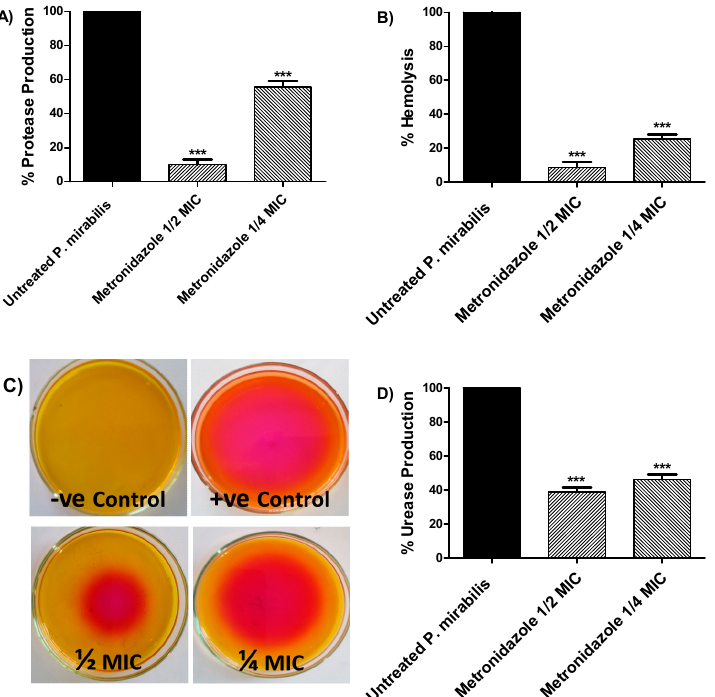
Figure 2. Effect of metronidazole in sub-MIC on P. mirabilis virulence enzymes. One-way ANOVA test was employed to compare between the metronidazole in ½ MIC or ¼ MIC treated and untreated bacterial cultures. The data were presented as mean ± standard error of percentage change from untreated cultures; and were considered statistically significant when p values < 0.05. ( A ) Protease production: significantly, metronidazole reduced the protease production in comparison to untreated cultures ( p < 0.0001). ( B ) Hemolytic activity: metronidazole in sub-MIC significantly decreased the hemolytic activity ( p < 0.0001). ( C , D ) Urease inhibition: Christensen’s urea agar plates containing different sub-MIC of metronidazole were used. The change in the color of the pH indicator from yellow to pink indicates the urease activity and pink zones were measured in mm. Metronidazole significantly reduced the production of ureases ( p < 0.0001), *** = p <